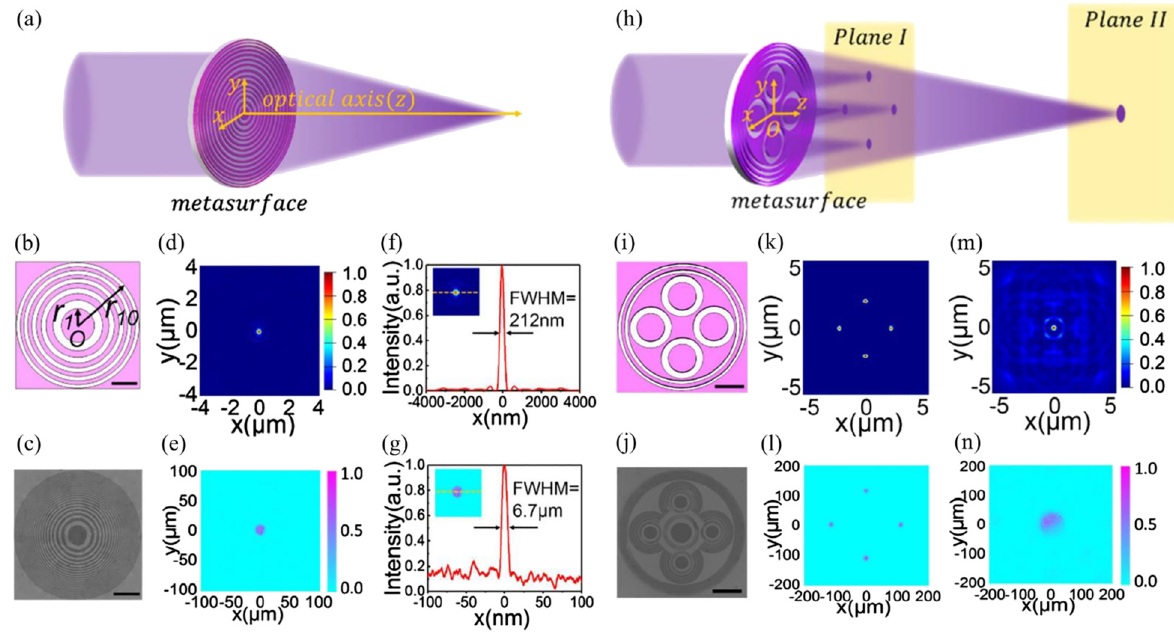
Figure 8: AlN-based metasurface devices working at UV wavelength ( λ = 375 nm). (a) Schematic of AlN-based metalens focusing in transmission mode. (b) Metalens simulation model, with ripple-like AlN pattern on sapphire substrate, and scale bar length of 1.6 μ m. (c) Optical image of fabricated metalens sample, with scale bar length of 60 μ m. (d) Simulated intensity distribution at the focal plane. (e) Measured intensity distribution at the focal plane. (f) Simulated intensity pro fi le at focal place along x -axis, withFWHMof212nm.(g)Measuredintensitypro fi leatfocalplacealong x -axis,withFWHMof6.7 μ m.(h)SchematicofAlN-based 3D routing in transmission mode, which is able to focus incident light into two different focal planes. (i) Simulation model of 3D router, with scale bar length of 1.7 μ m. (j) Fabricated metasurface for 3D routing, with scale bar length of 90 μ m. (k) and (m): Simulated light intensity distributionafternormalizationatfocalplaneI( z =3 μ m)andfocalplaneII( z =7 μ m),withFWHMof336and266nmatfocalspot,respectively. (l)and(n):MeasuredlightintensitydistributionafternormalizationatfocalplaneI( z =2mm)andfocalplaneII( z =5mm),withFWHMof20and 36 μ m at focal spot, respectively. (a) – (n) Adapted with permission from [88] © The Optical